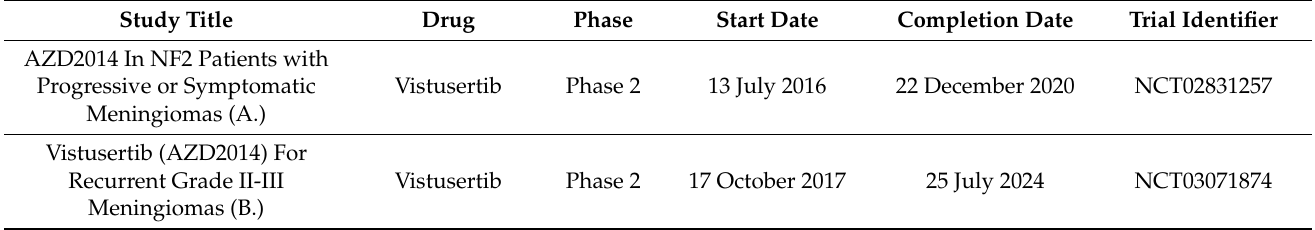
Table 3. Clinical trials on mTOR inhibitors in meningioma. Comprehensive summary of all clinical trials currently examining mTOR inhibitors in